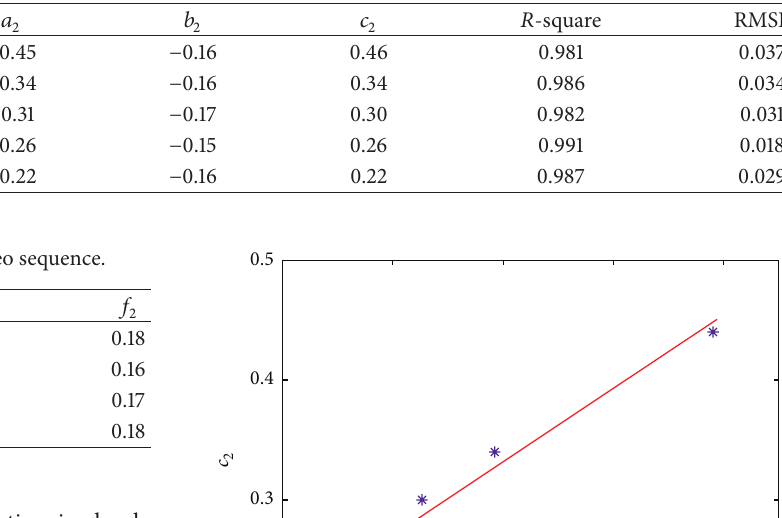
Table 3: Values of 𝑎 2 , 𝑏 2 , and 𝑐 2 for each video sequence.